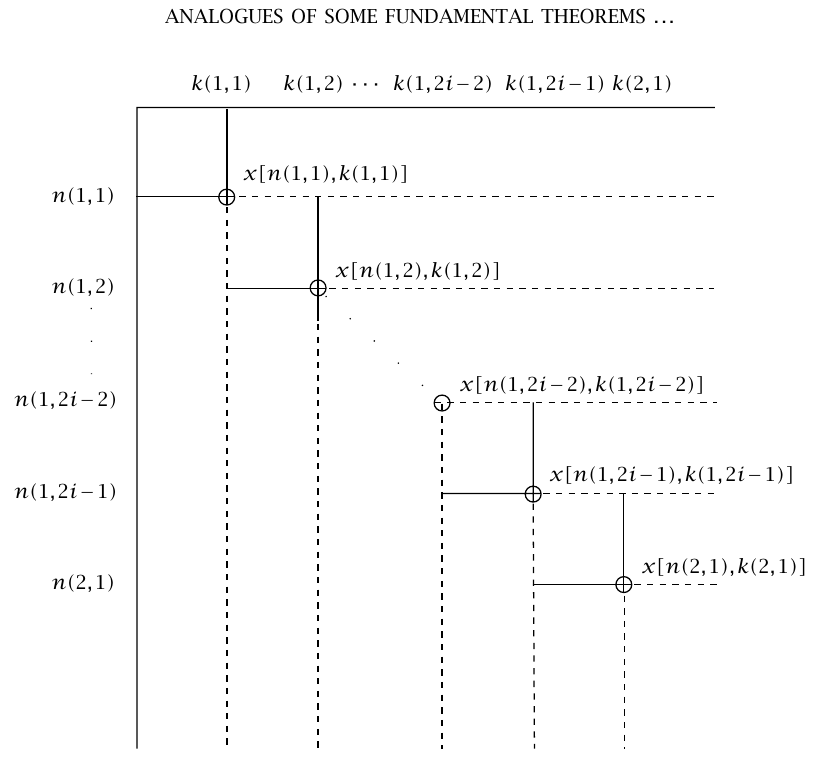
Figure 1 . The selection process of terms for subsequence y of x , where x[n(i,j),k(i,j)] = x